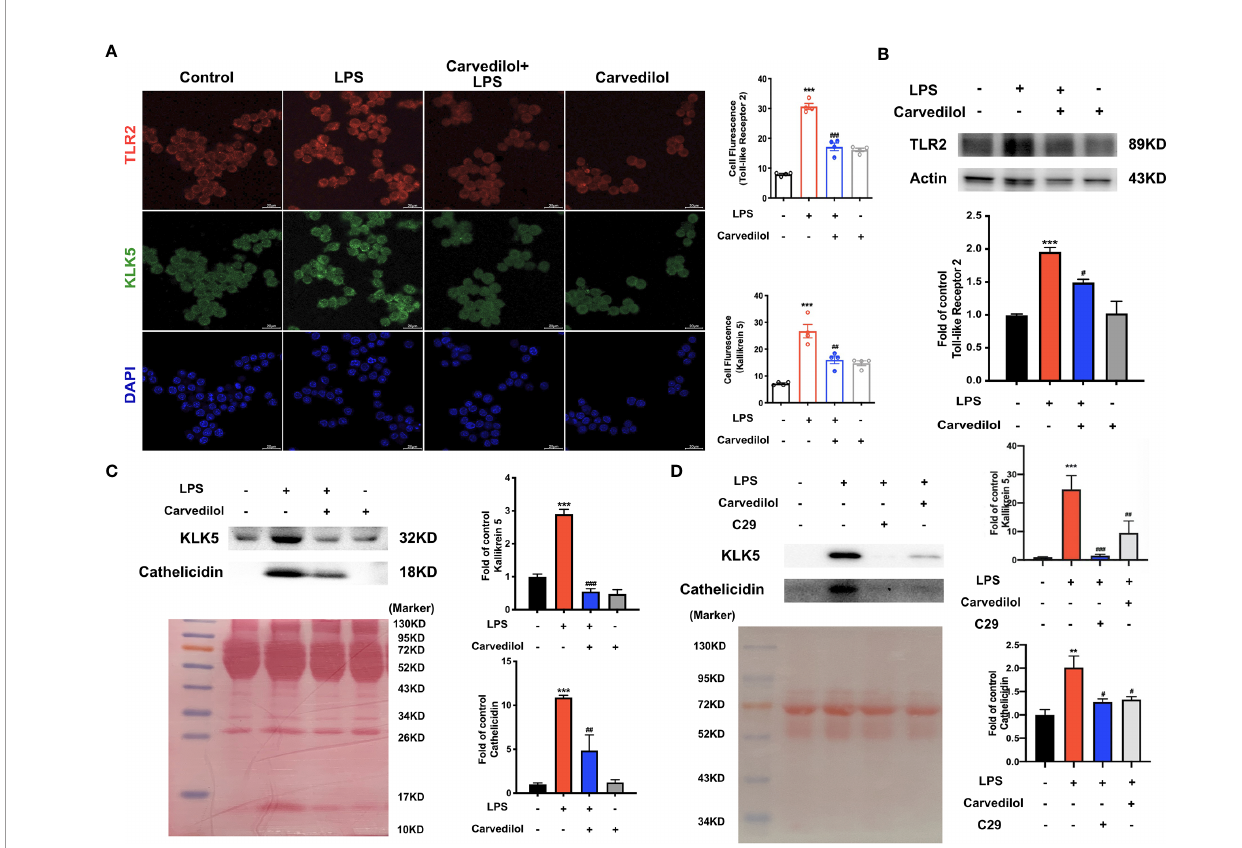
FIGURE 4 | Carvedilol alleviates the expression of TLR2, KLK5, and cathelicidin in RAW 264.7 cells induced by LPS. (A) Immuno fl uorescence staining of TLR2 and KLK5. Following induction by LPS, the expression of TLR2 and KLK5 was signi fi cantly elevated, whereas expression was reduced by carvedilol pretreatment in the LPS+carvedilol group. (B, C) Western blot results of TLR2, KLK5, and cathelicidin expression showed an increase in the LPS group and decrease in the LPS +carvedilol group. (D) Western blot results of KLK5, and cathelicidin expression illustrated the same trend in the LPS+carvedilol and LPS+C29 group. **P < 0.01, ***P < 0.001, # P < 0.05, ## P < 0.01, ### P <